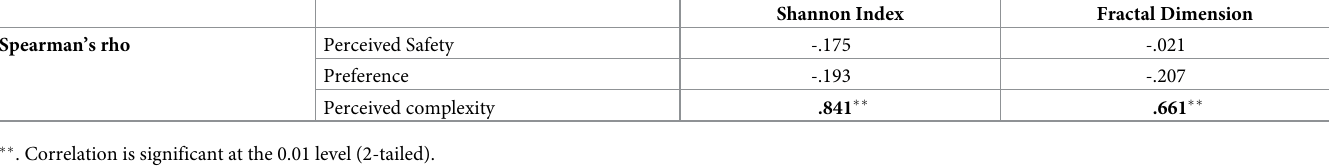
Table 2. Spearman’s rho values for the measures of complexity and perceptual qualities.